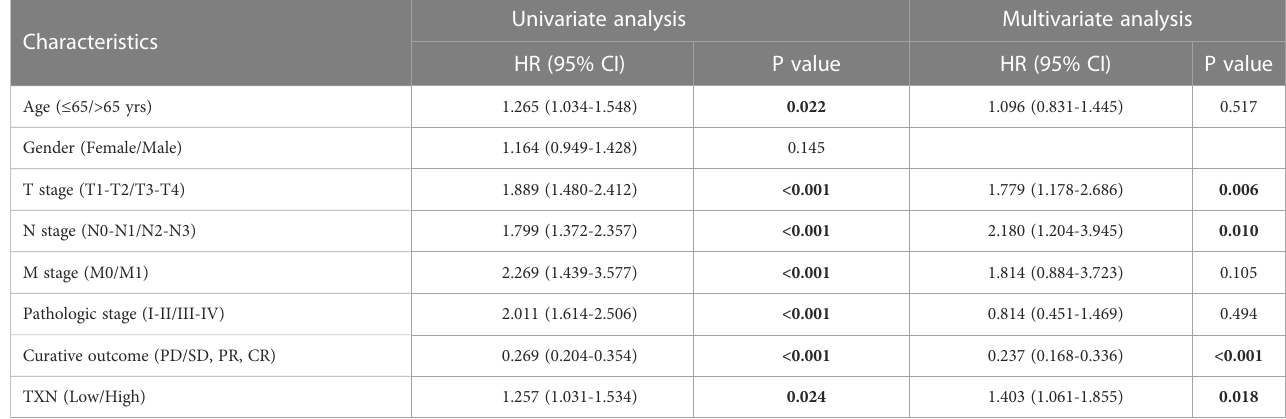
TABLE 3 Univariate/multivariate Cox regression.